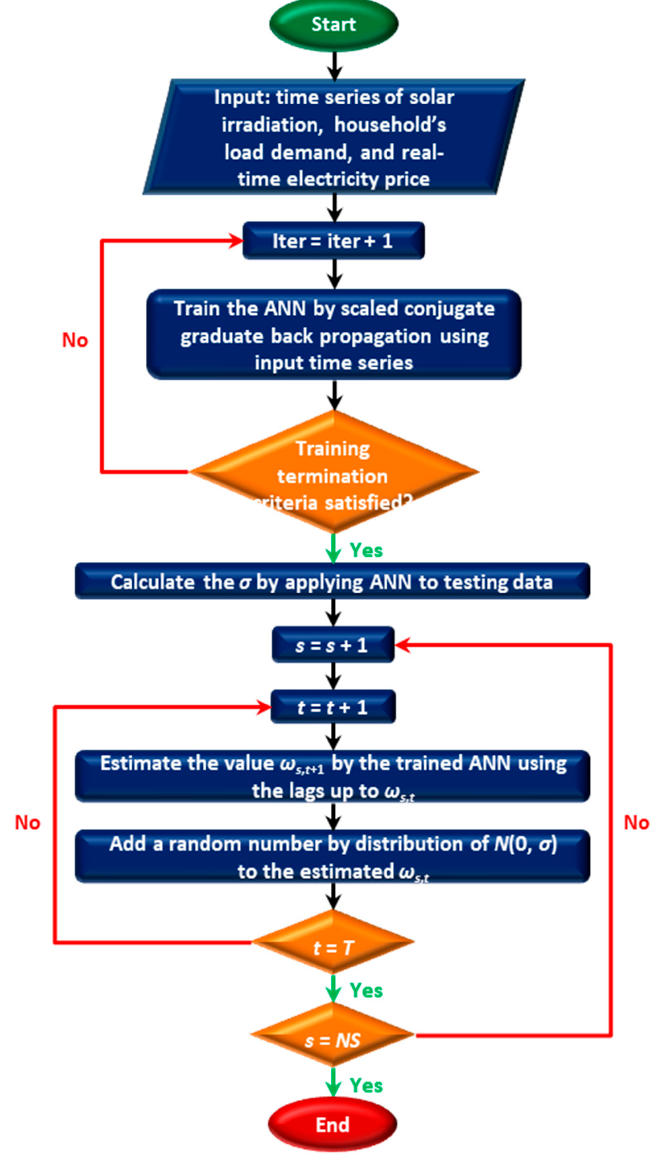
Figure 21. The flowchart diagram of the proposed scenario generation algorithm.